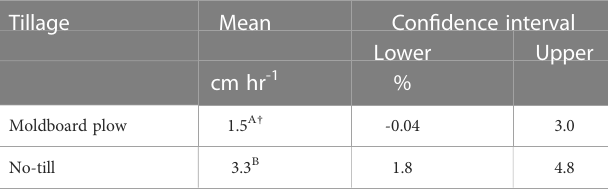
TABLE 3 Soil saturated hydraulic conductivity for the moldboard plow and no-till at the long-term tillage experiment (phase C) that was modi fi ed in 2010/2011 season.